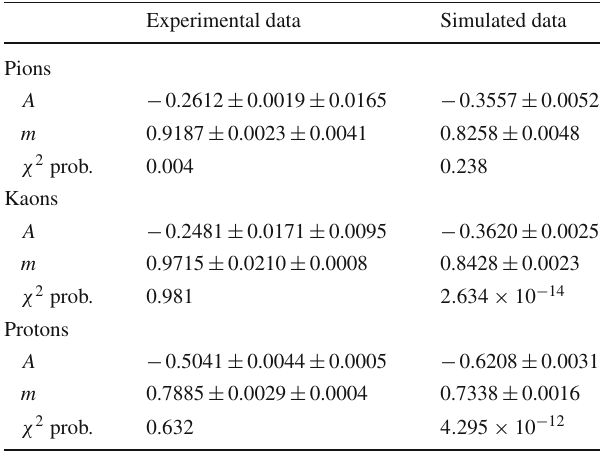
Table 12 Values of the parameters A (Eq. (29)) and m obtained fitting Eq. (22) to the experimental and simulated energy response normal- ized to incident beam energy, R E raw , as a function of E beam . The fit functions are overlapped to the determinations in Fig. 20. In the case of experimental data results statistical and systematic uncertainties are reported. Only statistical uncertainties appear in the case of simulated data results. The χ 2 probability values of the fits are